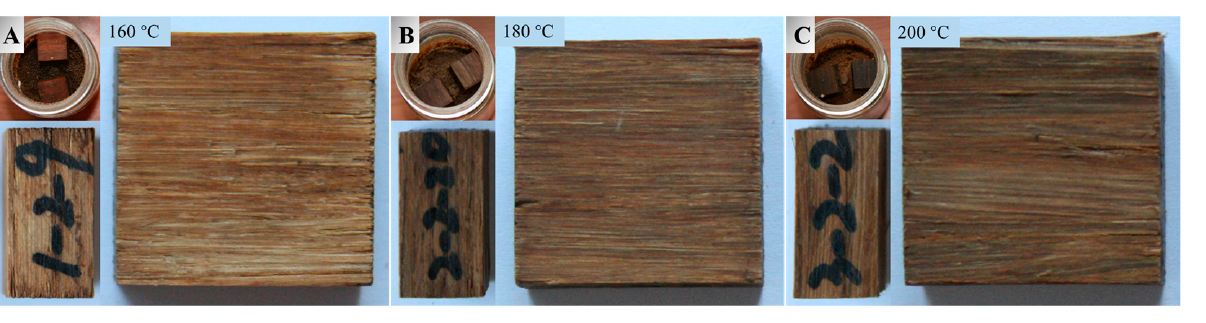
Figure 10. Surfaces of ( A ) 160, ( B ) 180 and ( C ) 200 ◦ C -treated bamboo scrimbers attacked by brown-rot fungi. Table 3. Mass loss and decay resistance grade of bamboo scrimbers after fungi